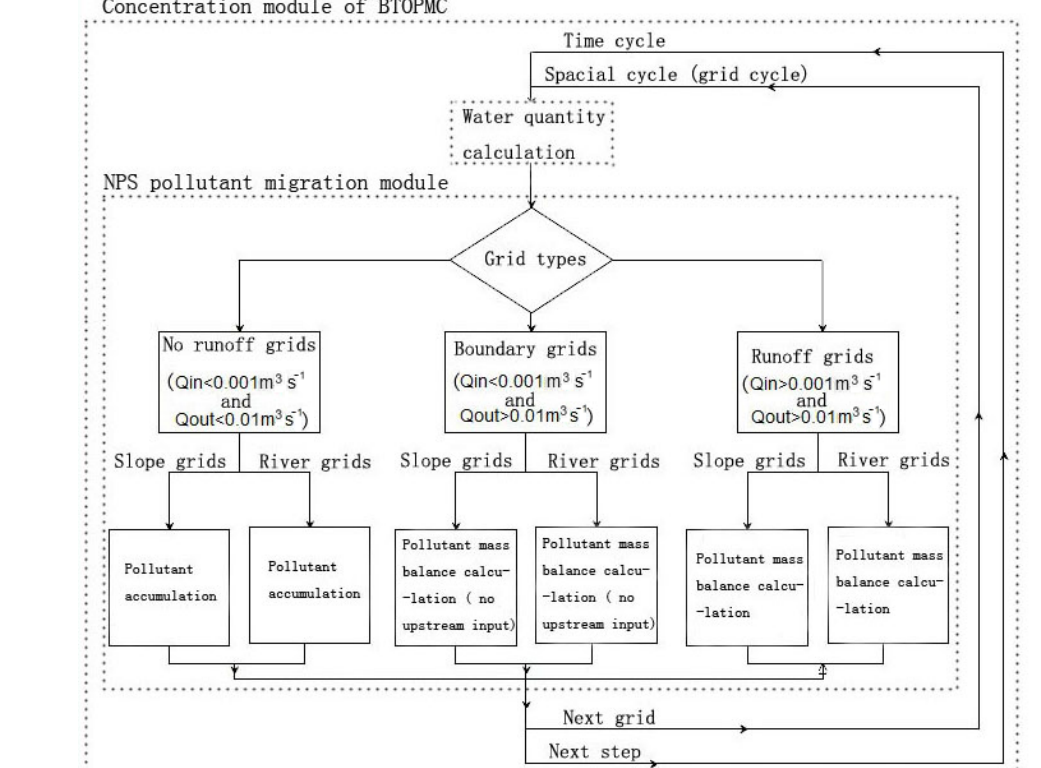
Figure 1. Framework of NPS pollutant transport